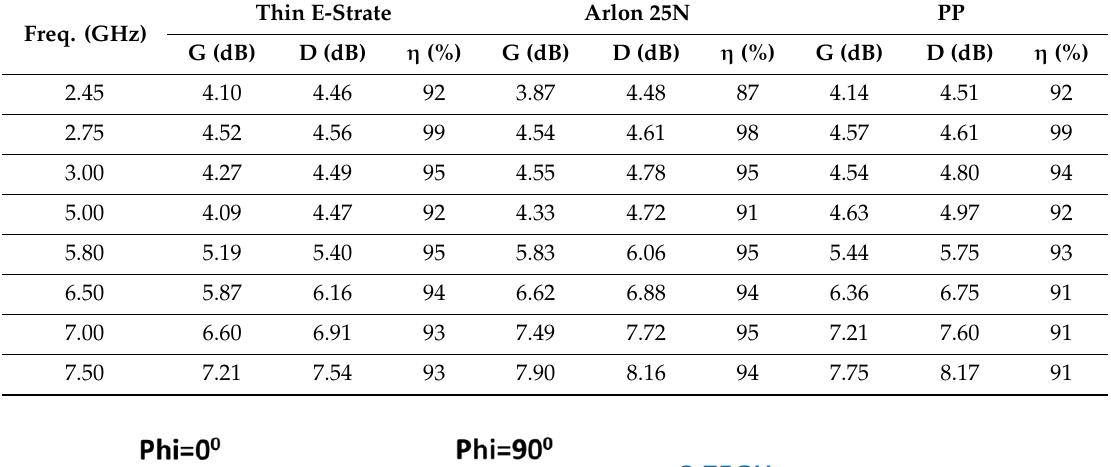
Table 4. Radiation properties of the CPW-fed monopole antenna obtained in simulation for different dielectric substrates.